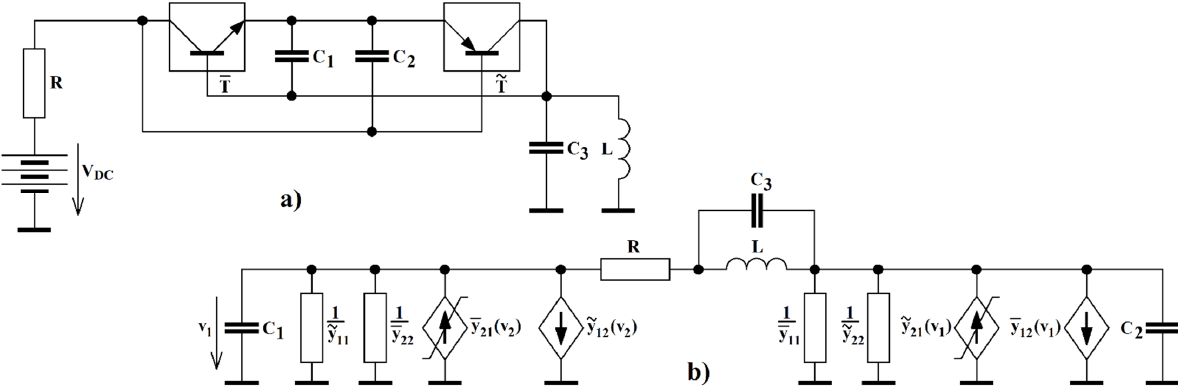
Figure 2. Negative resistance oscillator with a resistor-biased lambda diode: ( a ) principal schematic considering generalized bipolar transistors, ( b ) equivalent small-signal model with the nonlinear voltage controlled current sources.